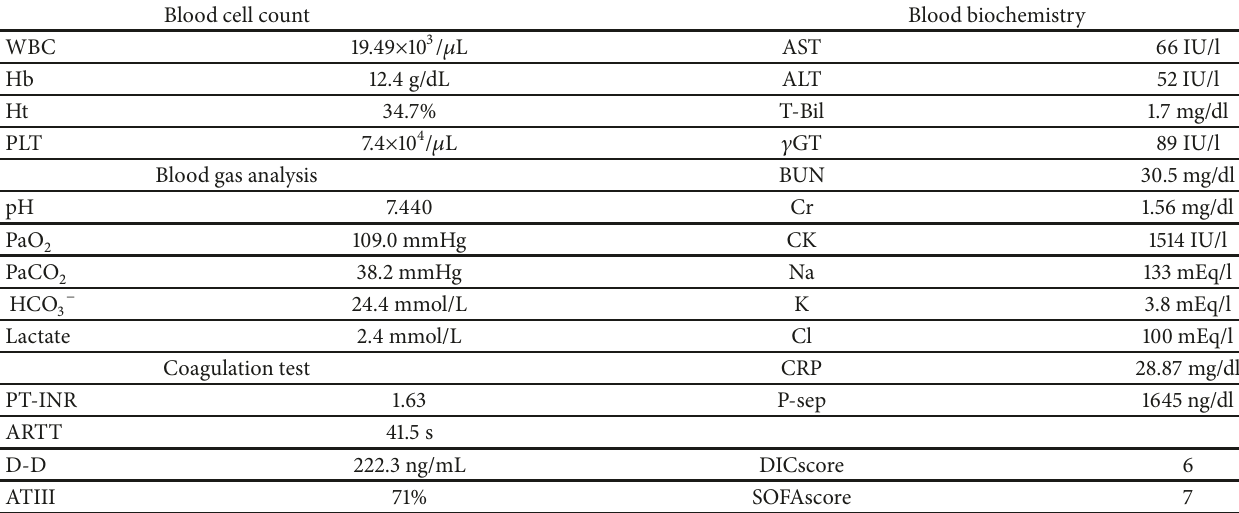
Table 1: Laboratory data at 0:30am on day 5.